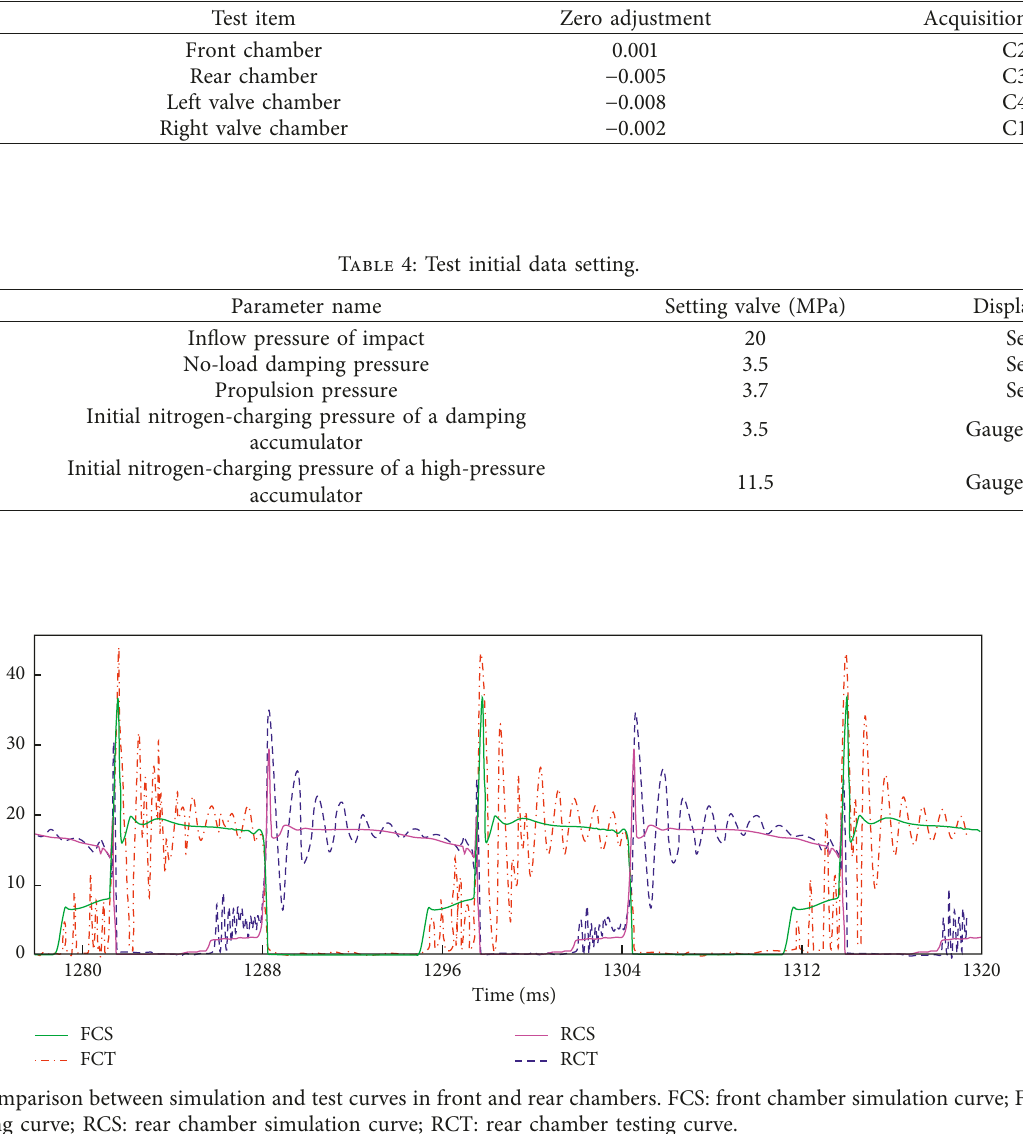
Figure 9: Picture of the experiment: (a) the connection between the computer and LMS data collection; (b) the connection between the hydraulic rock drill and Table 3: Signal amplifier zero setting.